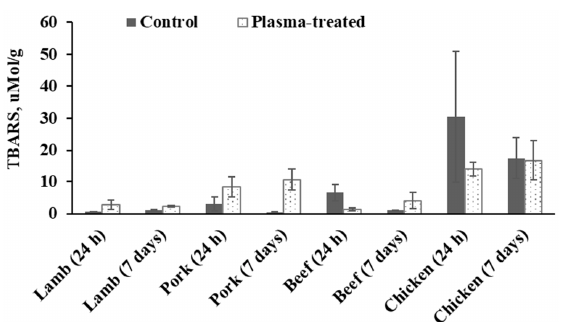
Figure 7. Thiobarbituricacid reactive substances (TBARS) value of control and plasma-treated meat samples. TBARS are presented in µMol/g lipid.